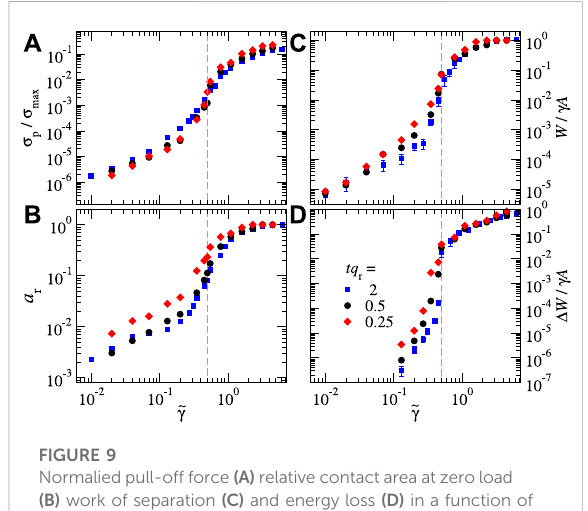
Normalied pull-off force (A) relative contact area at zero load (B) work of separation (C) and energy loss (D) in a function of reduced surface energy for a broader range of sheet thicknesses from q r = 2, 0.5 and